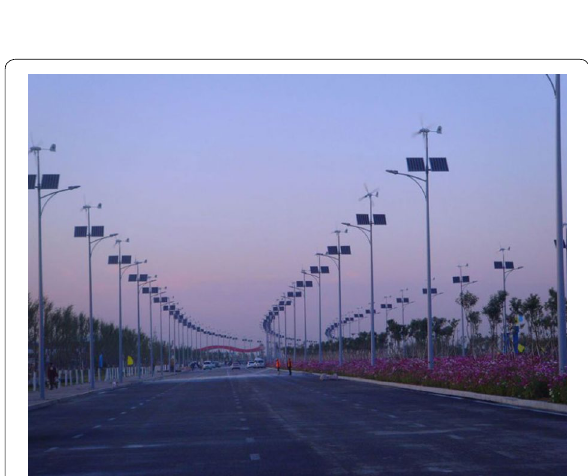
Fig. 7 OFF-grid street lamps at Bargallò, Spain (http://www.walln ews24 .it/2018/01/04/santo mero-conve nzion e-attiv ata-pali-fotov oltai ci-delli llumi nazio ne-pubbl